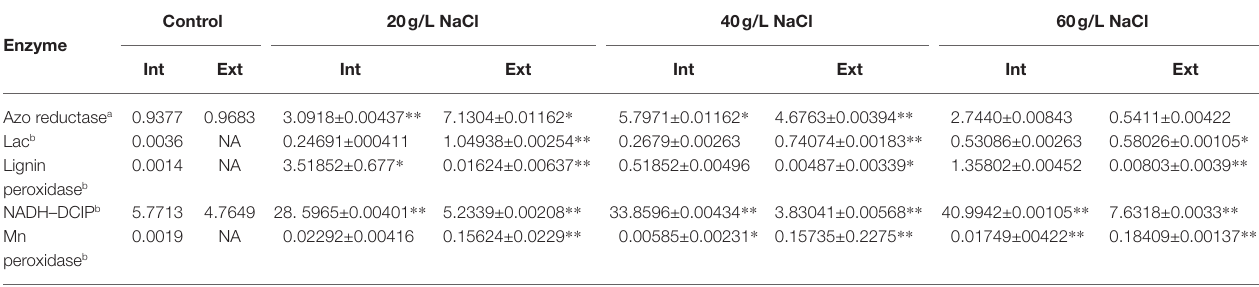
TABLE 3 | Enzyme activities in the supernatant and microbial cells before (control) and after decolorization of 600 mg/l DBG.